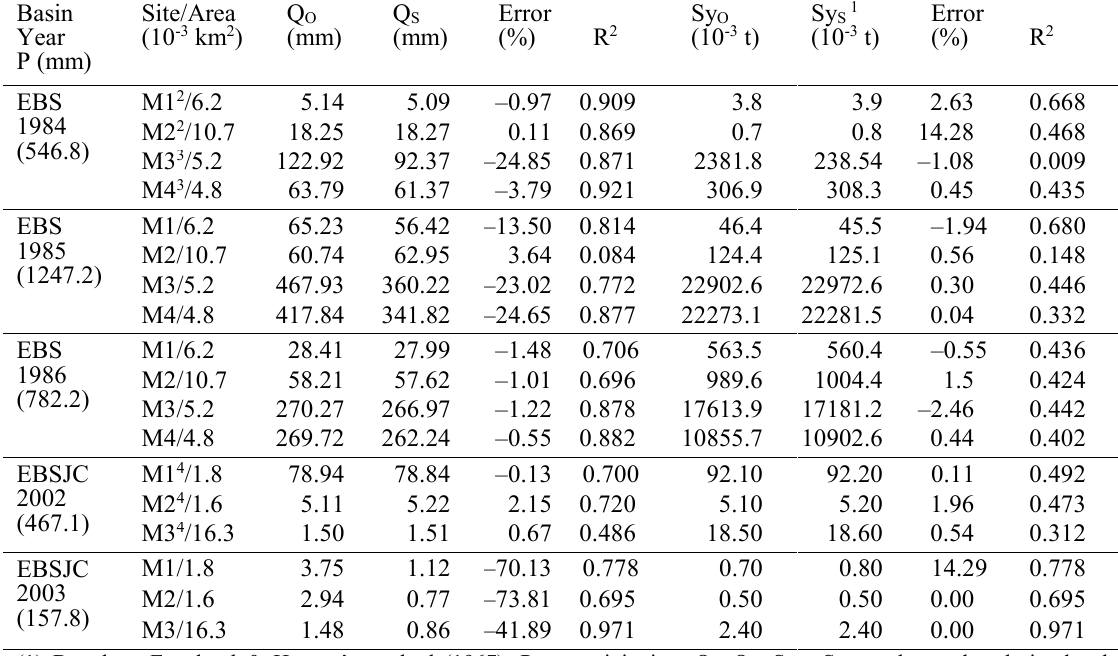
Table 2 Annual runoff (Q) and sediment yields (Sy) in the EBS and EBSJC micro-basins. Basin